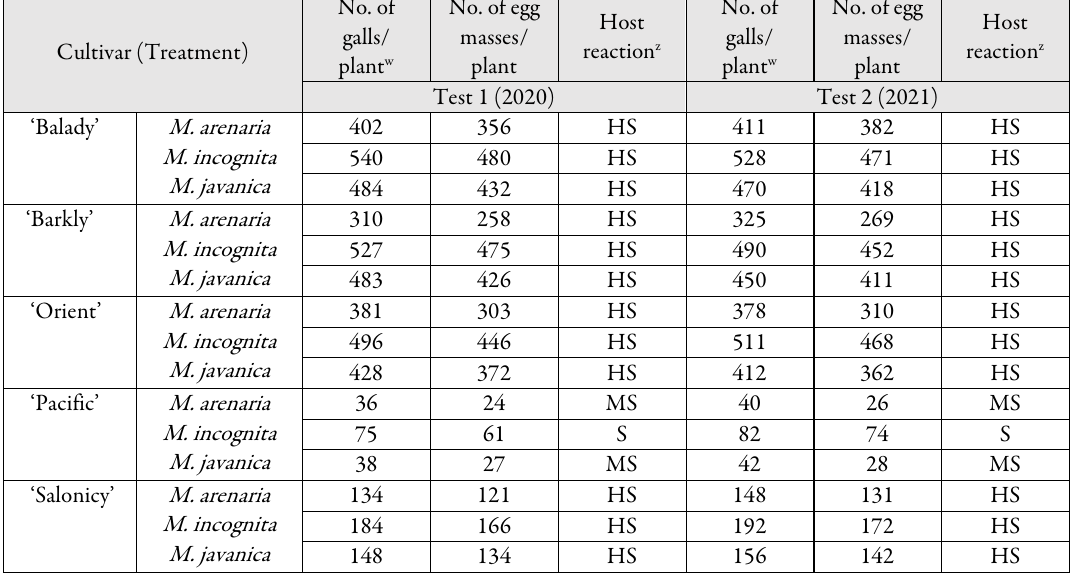
No. of No. of egg No. of No. of egg Host Host galls/ masses/ galls/ masses/ reaction z reaction z plant w plant plant w plant Test 1 (2020) Test 2 (2021)